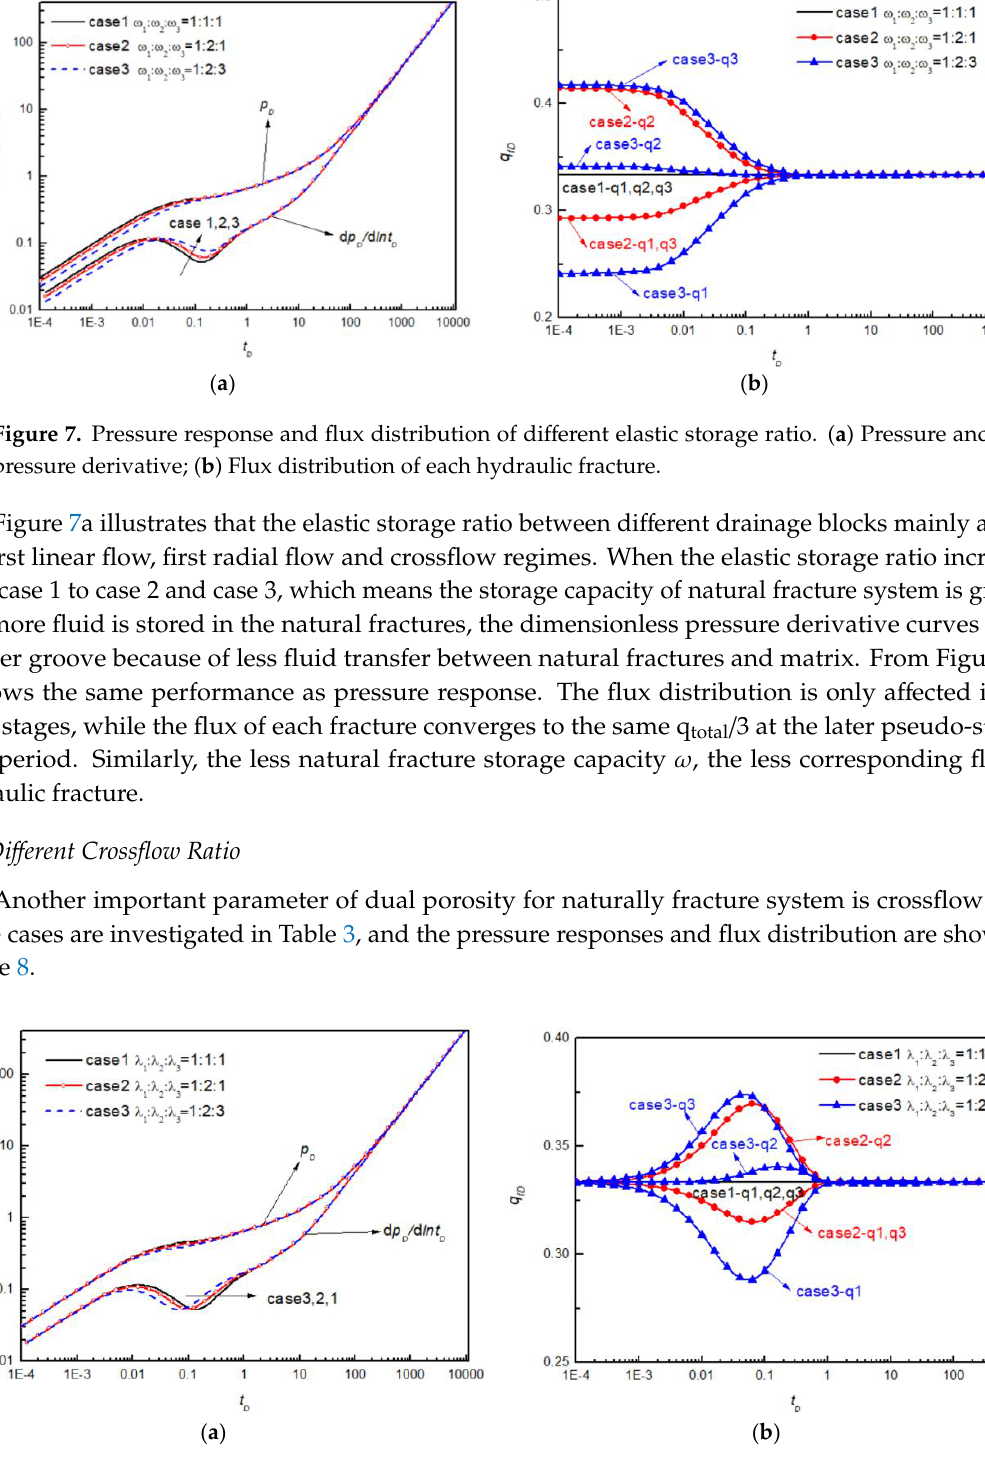
( b ) Figure 6. Pressure response and flux distribution of non-uniform length distribution. ( a ) Pressure and pressure derivative; ( b ) Flux distribution of each hydraulic fracture. From Figure 6a, we can see that if the whole drainage length is constant, the dimensionless pressure drop and pressure derivative curves have no change when the drainage length of each fracture is different. However, in Figure 6b, the flux distribution of each fracture is different after